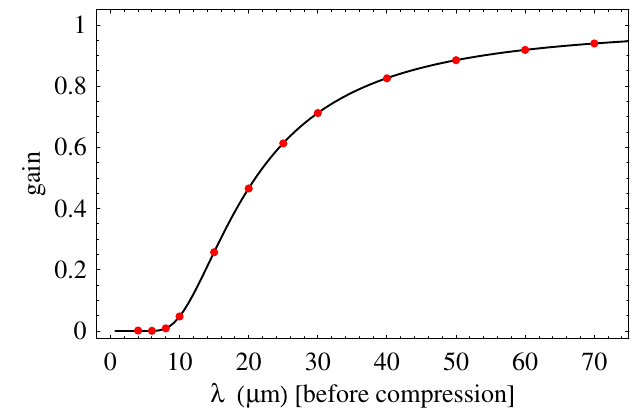
FIG. 5. (Color) The exact (solid line) gain function through the FERMI first bunch compressor at vanishing current is compared to that determined from numerical solutions of the Vlasov equation